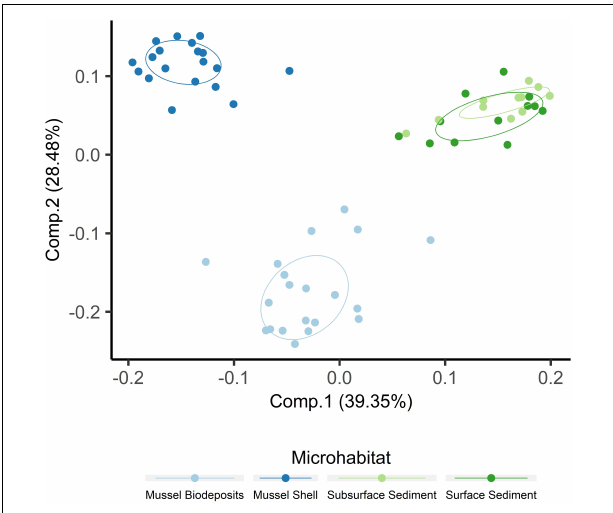
FIGURE 2 | Principal coordinates analysis including samples from all microhabitats. Ellipses are drawn around centroids with a 50% confidence interval.